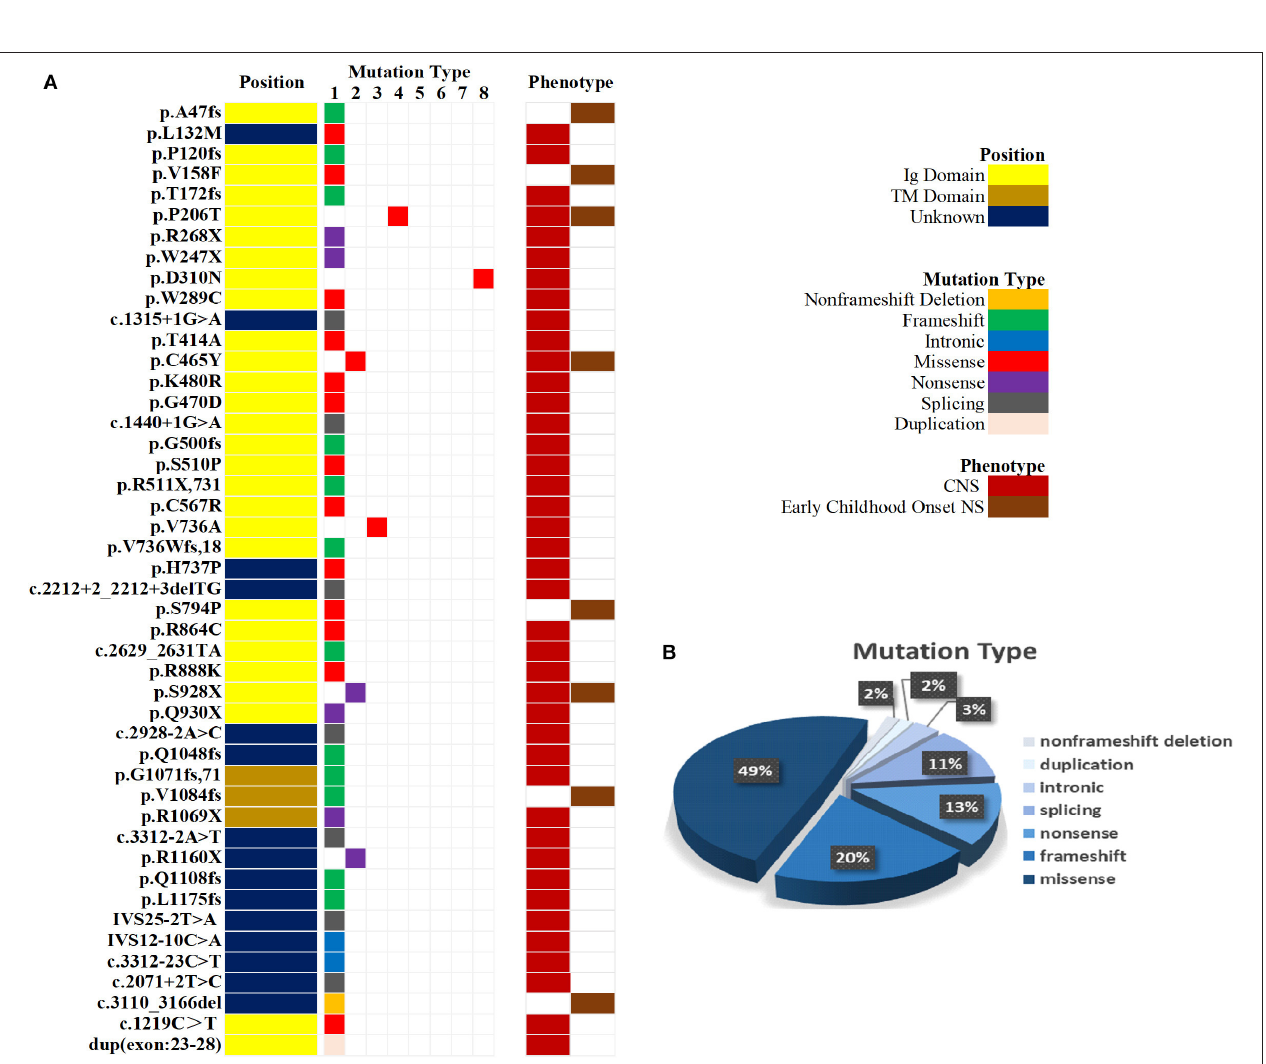
FIGURE 2 | An overview of variants according to NPHS1 gene type. (A) Mutation type and phenotype of NPHS1 in 30 patients. (B) Percentages of variants according to NPHS1 gene type.